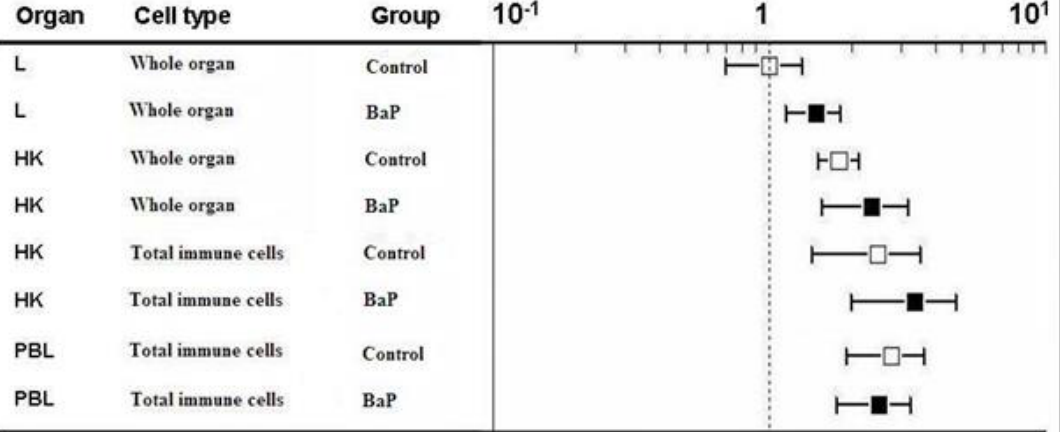
Figure 5. ahr2 β gene expression levels of liver (L), head kidney (HK), immune cells isolated from head kidney and immune cells from peripheral blood (PBL) are shown. The immune cells were not sorted but the total population as obtained from the isolation process was used. The RT-qPCR data were calculated using the 2 − ( ∆∆ ct) method. Gene expression level of the liver of control rainbow trout was set to be 1 and the mRNA expression levels of the other treatments were compared to the control liver (note: log scale on the top x -axis). Data represent mean values ± SD from 10 fish per treatment. PBL = peripheral blood immune cells. Table 3. Induction of ahr2 β mRNA mRNA transcripts in organs and cells of BaP-exposed rainbow trout relative to ahr2 β transcript levels in the respective organs and cells of control rainbow trout. Organ Cell Type Control BaP L Whole organ 1 ± 0.31 1.48 ± 0.33 HK Whole organ 1 ± 0.17 1.32 ± 0.46 HK Total immune cells 1 ± 0.43 1.36 ± 0.56 PBL Total immune cells 1 ± 0.31 0.90 ± 0.27 ahr2 α gene expression levels in liver (L), head kidney (HK), immune cells isolated from head kidney and immune cells isolated from peripheral blood (PBL) of BaP-exposed rainbow trout relative to control fish. Data were analyzed using the 2 − ( ∆∆ ct) method. Gene expression levels in organs and cells of BaP-exposed fish were compared to the mRNA levels in the respective organs and cells of the control fish, which were set to be 1. Data represent mean values ± SD from 10 fish per treatment. Asterisks indicate significant di ff erences to control ( p < 0.05). PBL = peripheral blood immune